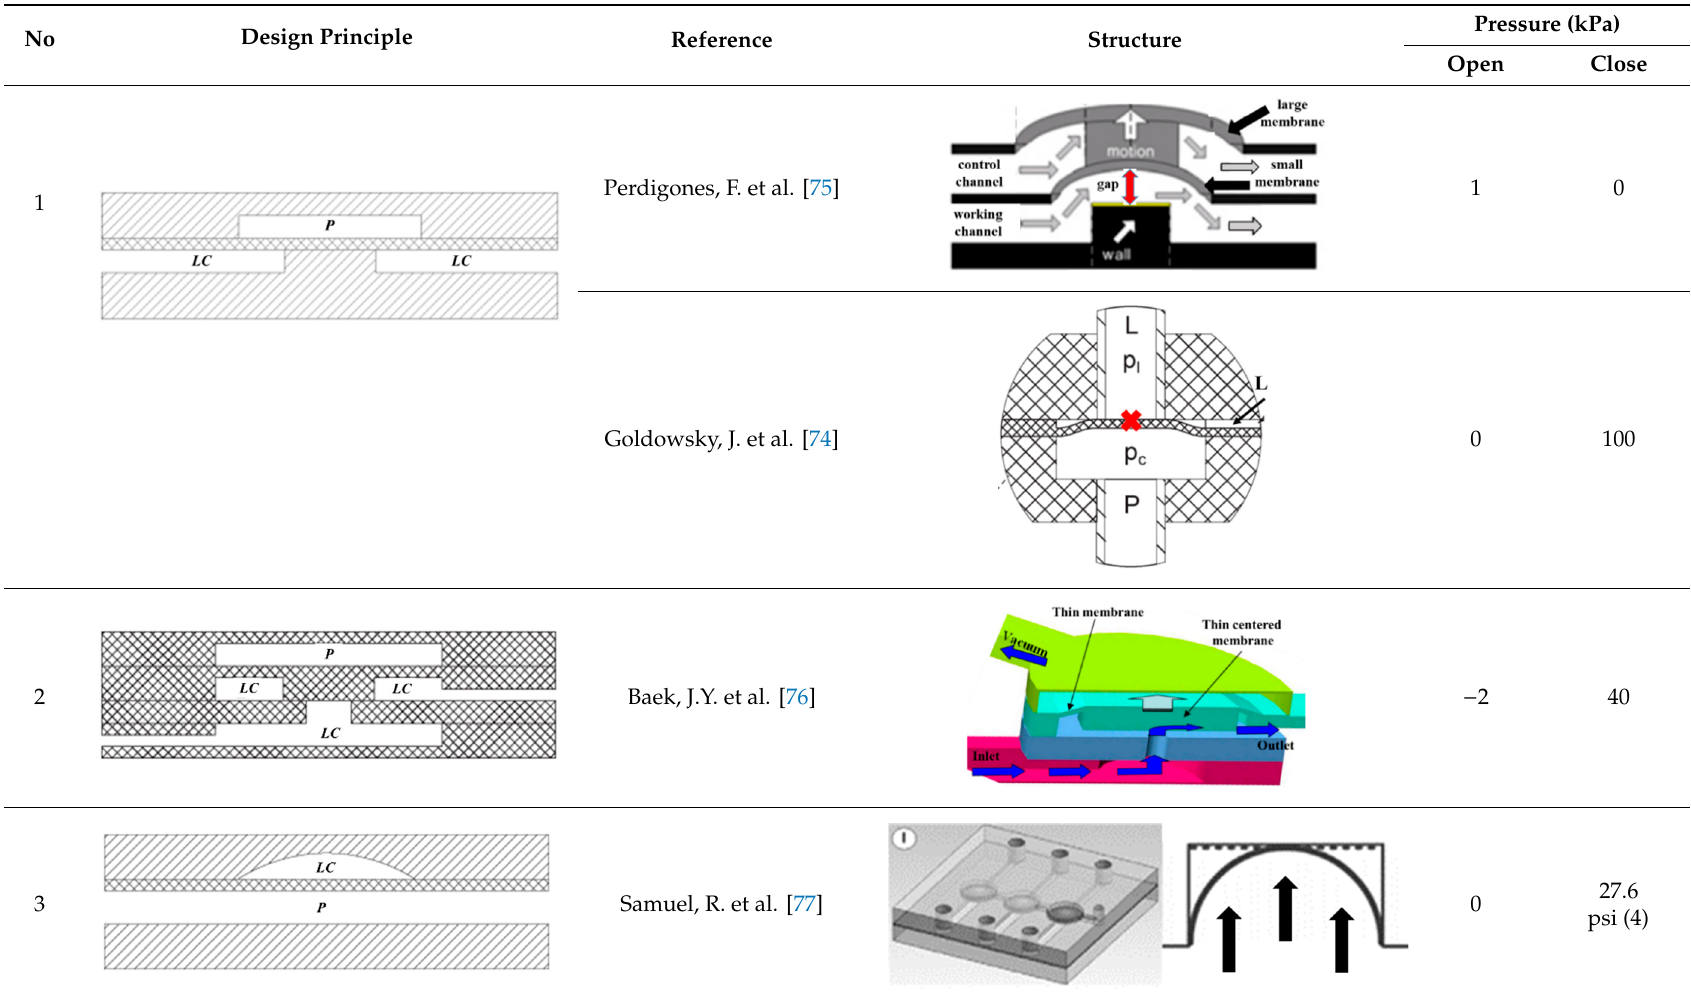
Table 4. Three design principles of pneumatic microvalves. The marking LC stands for liquid channel, P is for pressure, indicating the volume where the pressure for opening or closing is applied, cross-hatch is a PDMS layer, diagonal-hatch glass or thermoplastic layers [74].